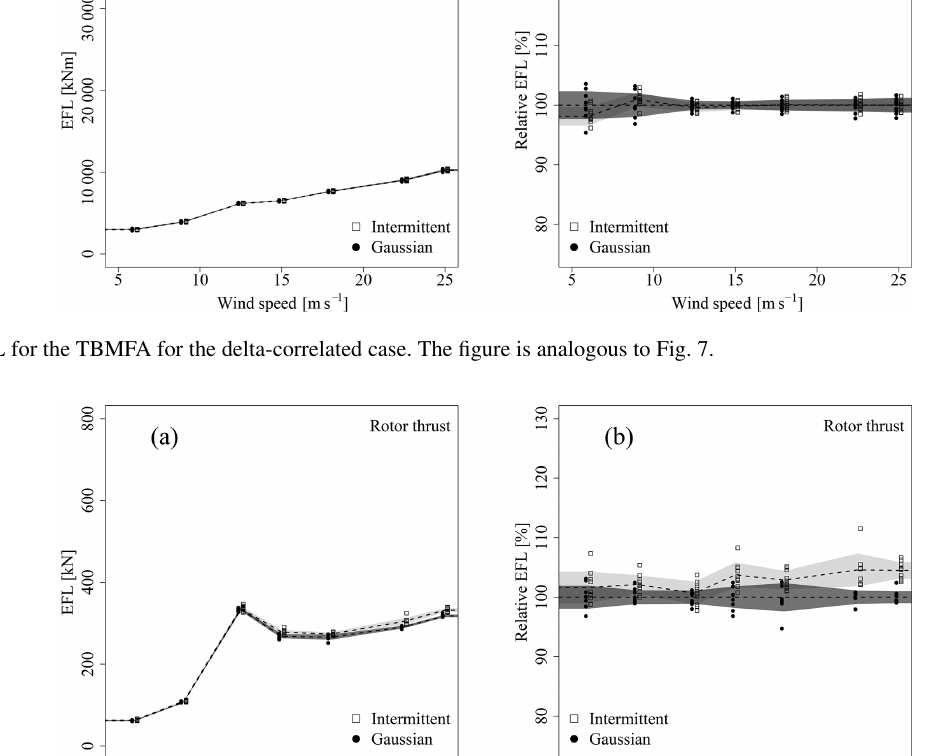
some remaining non-Gaussianity; however, it is much lower compared to the fully correlated